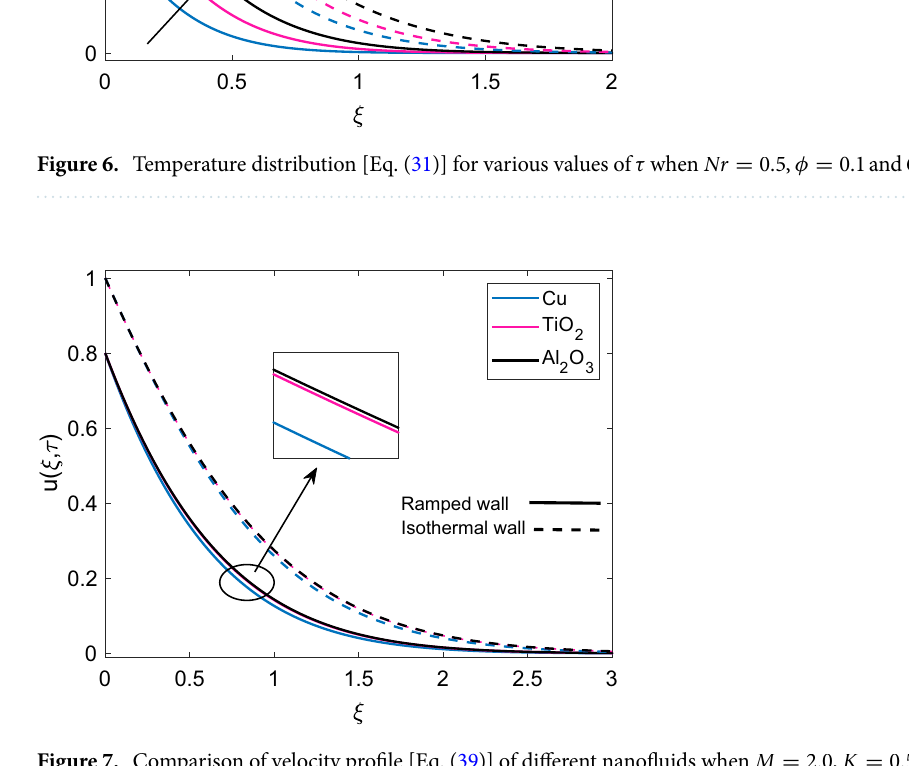
Figure 7. Comparison of velocity profile [Eq. (39)] of different nanofluids when M = 2.0 , K = 0.5 , Gr = 5.0 , Nr = 0.5 , φ = 0.1 and Q = 0.5